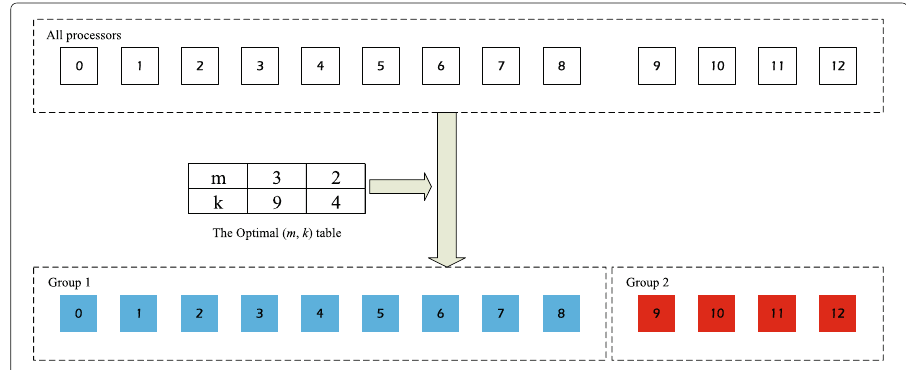
Fig. 3 Grouping according to the optimal ( m , k ) table. In the optimal ( m , k ) table, the combination of m = 3, k = 9 is better than m = 2, k = 4. mSwap assigns processors 0 to 8 into the group 1 in priority, and the rest is grouped into group 2